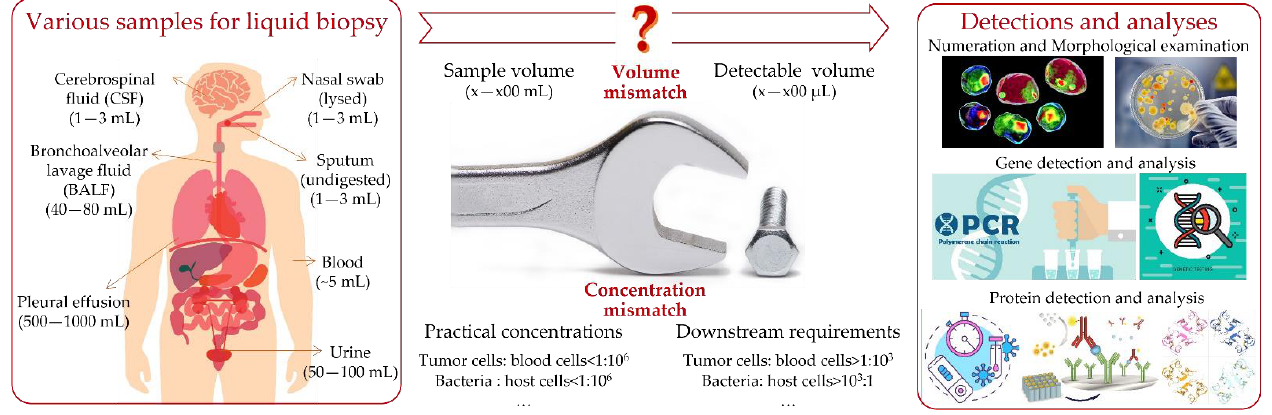
Figure 1. Schematic illustration of the gap between the raw samples and detection/analysis platforms in the practices of liquid biopsy. All the images used here were commercially bought from iStock (https://www.istockphoto.com) on 23 January 2022 with issued copyright for reprint. Microfluidics is poised to impact and transform the biomedical research and clinical